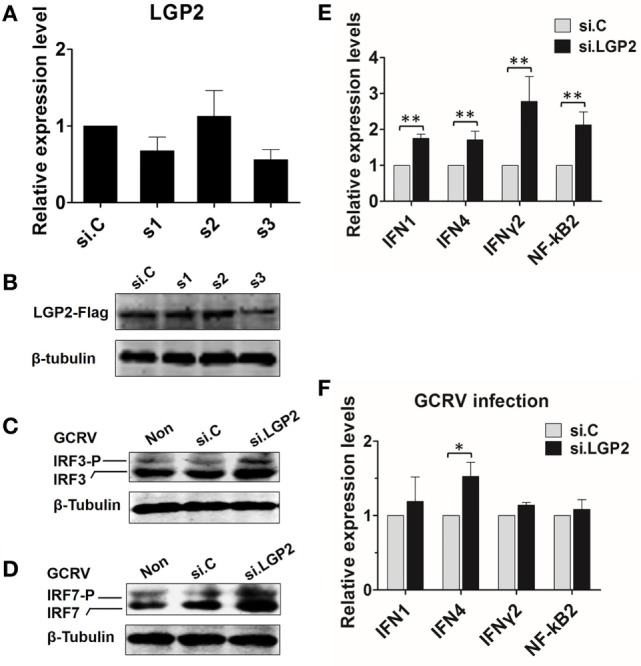
Knockdown of laboratory of genetics and physiology 2 (LGP2) potentiates grass carp reovirus (GCRV)-mediated activation of innate immune responses in Ctenopharyngodon idella kidney (CIK) cells. (A) Screening LGP2 interference sequences. Three siRNA sequences (s1, s2, and s3) along with the negative control si.C were transiently transfected into CIK cells. The cells were harvested for qRT-PCR at 24 h post-transfection to detect the transcription level of LGP2. (B) Examining the interference efficiency of the three siRNA in protein level. LGP2-Flag stable transfected CIK cells were transiently transfected with s1, s2, s3, and si.C in 6-well plates. Twenty-four hours later, cell lysates were prepared for IB using anti-Flag Ab. (C,D) Knockdown of LGP2 upregulates the protein levels of IRF3 and IRF7 induced by GCRV infection. CIK cells were transfected with s3 in 6-well plates. Twelve hours later, cells were infected with GCRV for 12 h and WB was conducted with anti-IRF3 and anti-IRF7 antiserums, respectively. (E,F) CIK cells were transfected with s3 and si.C, respectively, and treated or untreated with GCRV for 12 h. The cells were prepared for qRT-PCR to test the transcription levels of IFN1, IFN4, IFNγ2, and NF-κB2, respectively. Error bars indicate SD (n = 4). Asterisks indicate significant differences from control (*0.01 < P < 0.05; **0.001 < P < 0.01).